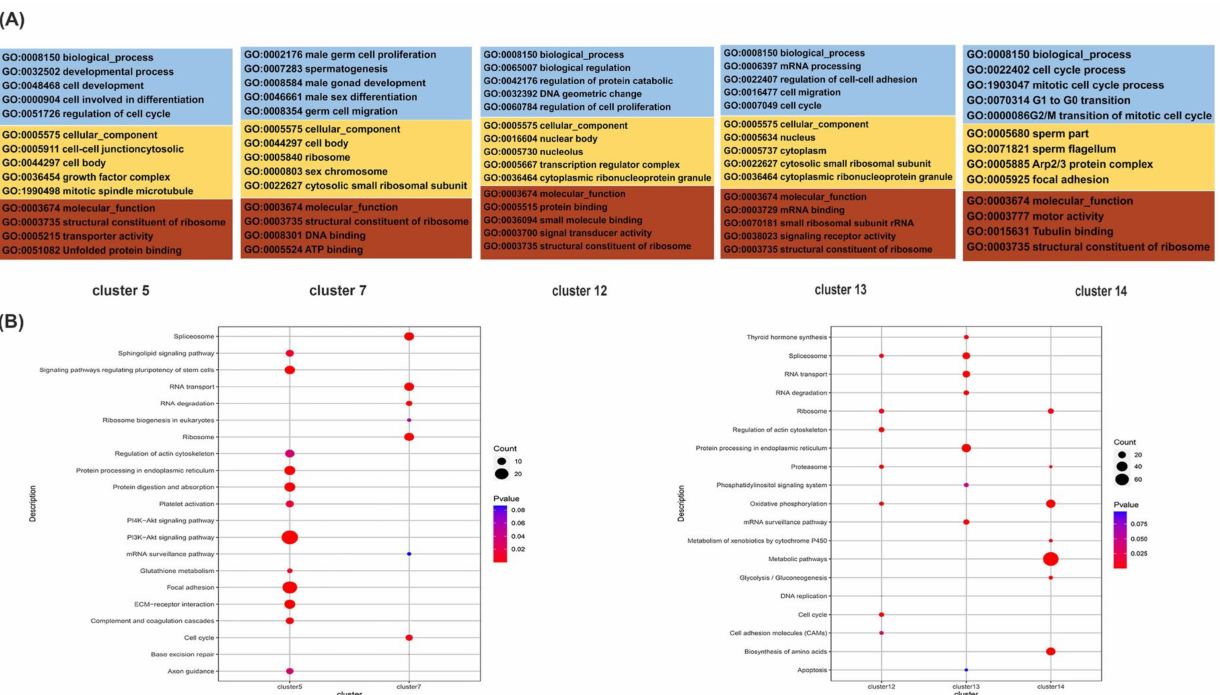
Figure 3. Functional enrichment analysis of testicular germ cell types. ( A ) The top GO analysis of five germ cell types. ( B ) The top KEGG analysis of five germ cell